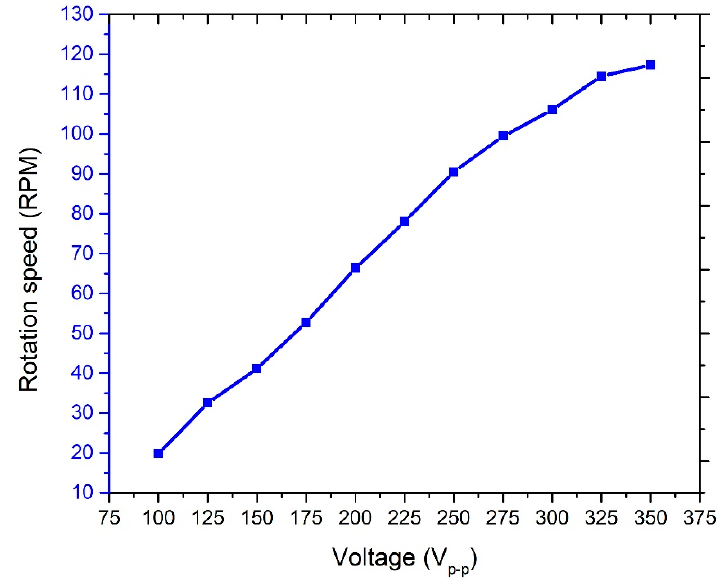
Figure 14. Rotation speed versus excitation amplitude at constant preload force.